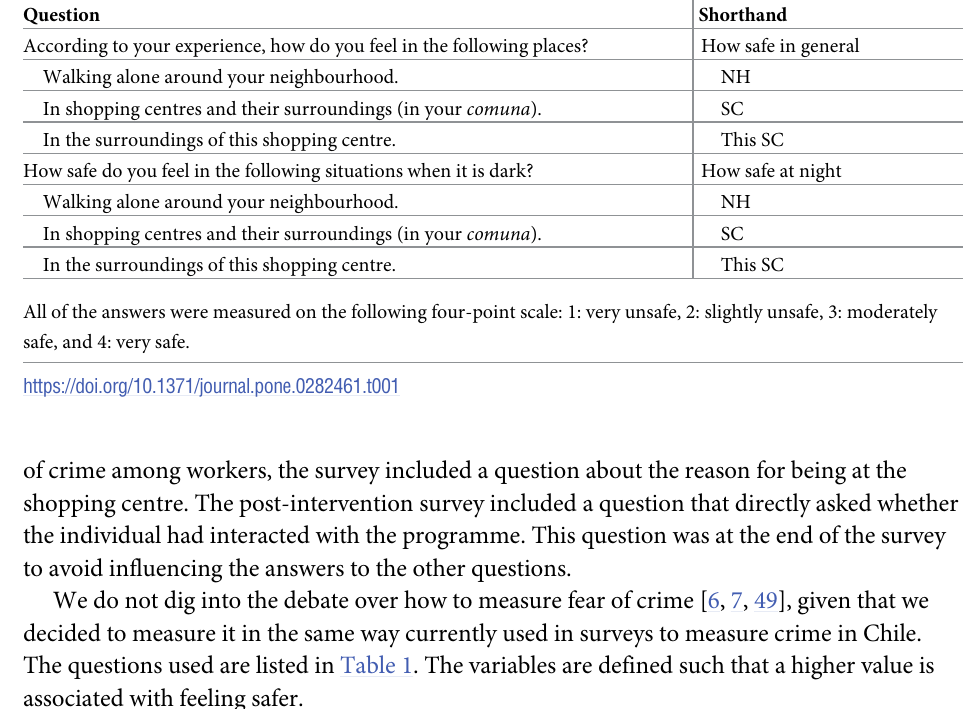
Table 1. List of fear of crime questions. Question Shorthand According to your experience, how do you feel in the following places? How safe in general Walking alone around your neighbourhood. NH In shopping centres and their surroundings (in your comuna ). SC In the surroundings of this shopping centre. This SC How safe do you feel in the following situations when it is dark? How safe at night Walking alone around your neighbourhood. NH In shopping centres and their surroundings (in your comuna ). SC In the surroundings of this shopping centre. This SC